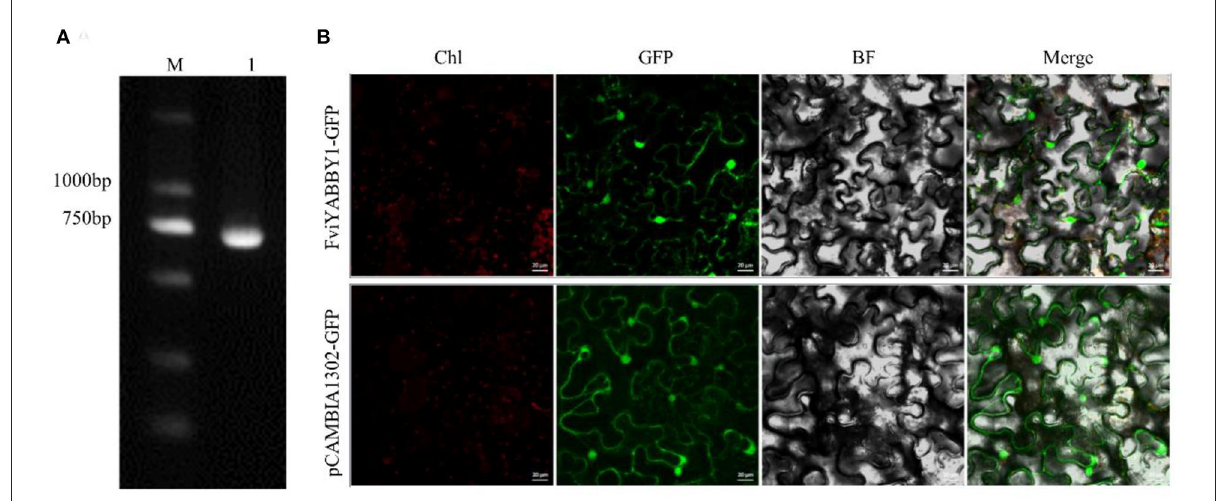
FIGURE7 Gene cloning and subcellular localization of FviYABBY1. (A) FviYABBY1 cloning. M: 2000 DNA Marker; 1: Fragment of FviYABBY1 CDS. (B) Subcellular localization of FviYABBY1. Chl, chlorophyl II autofluorescence; GFP, green fluorescence protein; BF, bright field; Merge, merged image of Chl, GFP, and BF. Bar = 20 µ